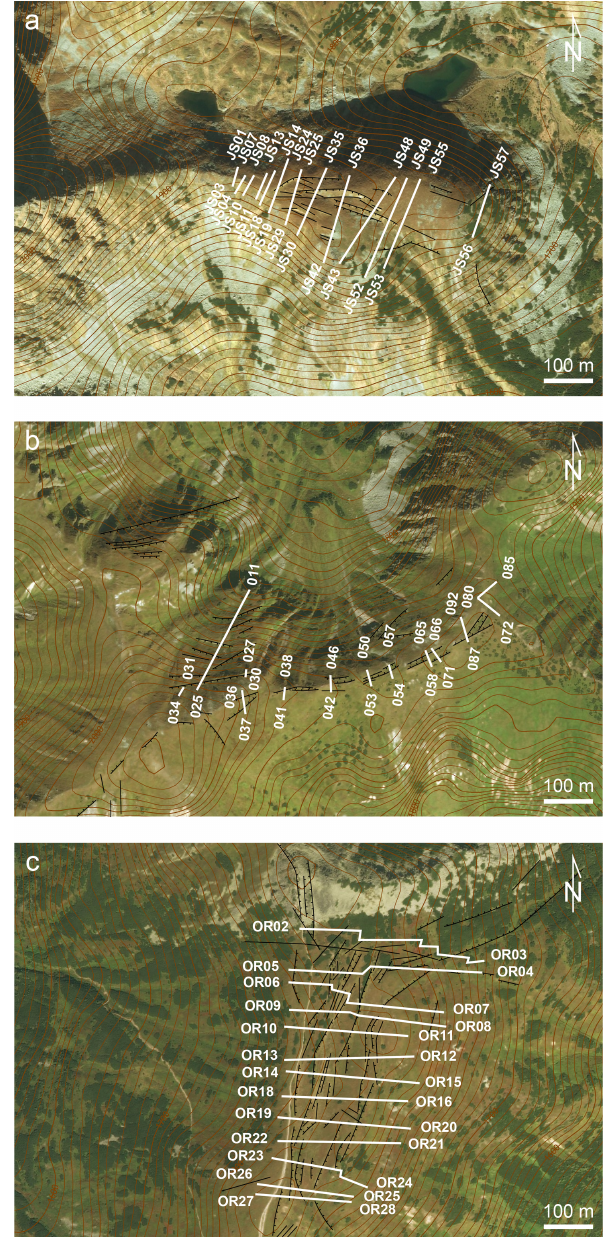
Figure 7. Terrestrial sites, location of the profiles. (a) Site T1, across a crest line east from Jamnícke Sedlo; (b) Site T2, the ridge west from Vel’ká Garajova Kopa; (c) Site T3, a ridge south from Ornak. Google Earth; 2015